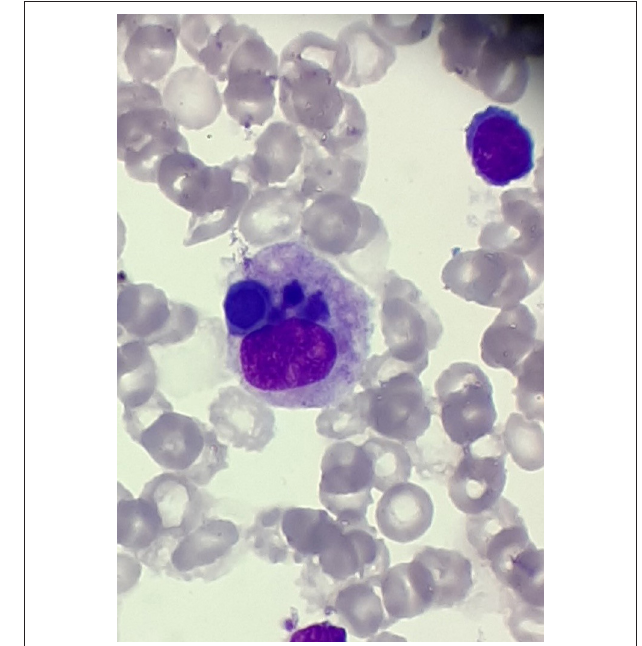
presenting SSChigh and high expression of CD45, CD64, CD14, and CD33, evaluated as macrophages (16% of all nucleated cells).